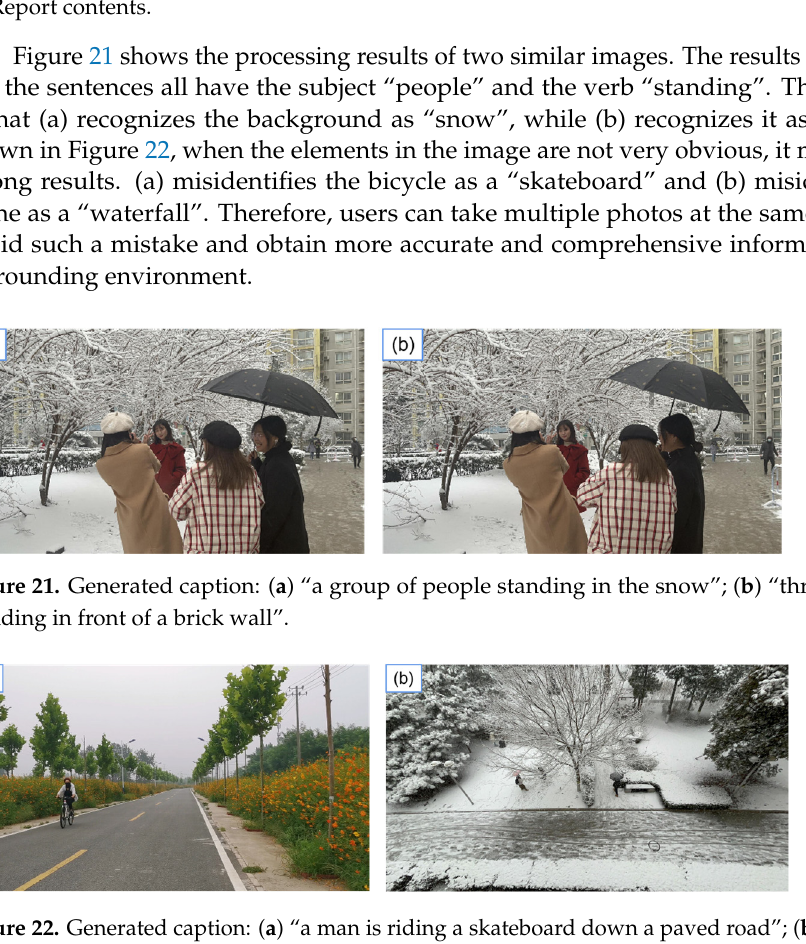
Report contents. Report contents. ( c )